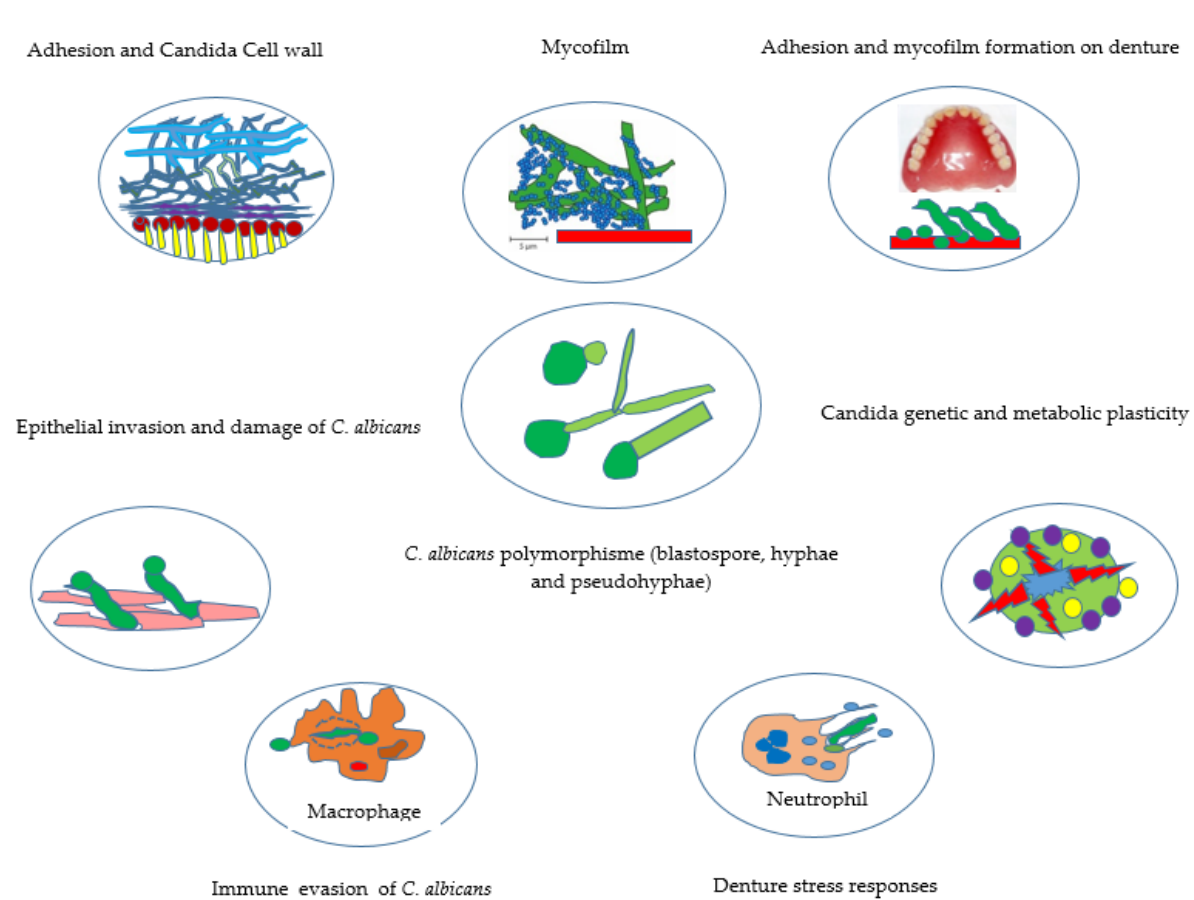
Figure 1. How does the presence of a removable prosthesis promote the virulence of C. albicans